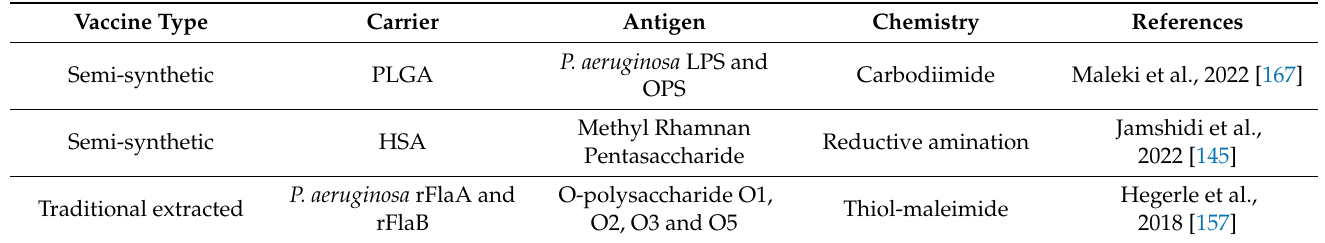
Table 12. Carbohydrate conjugate vaccines targeting Pseudomonas aeruginosa